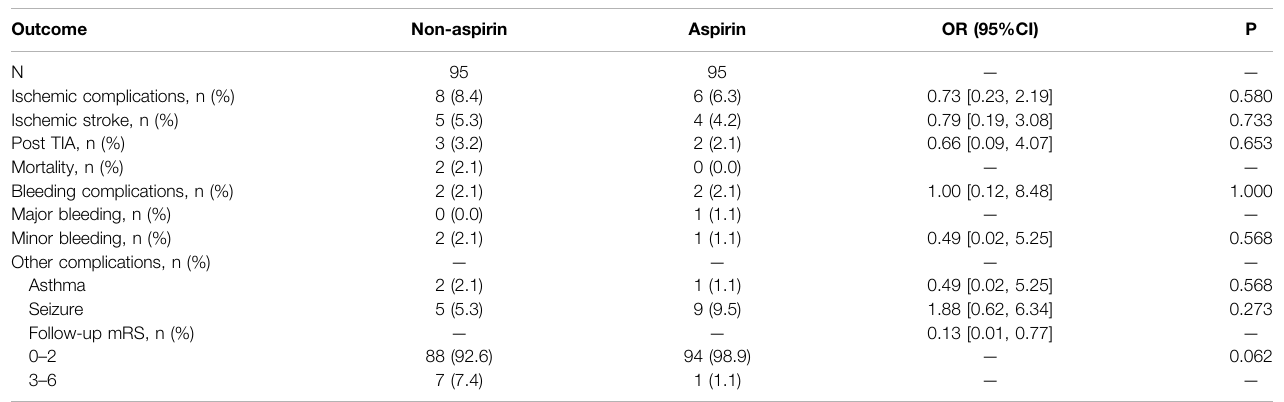
TABLE 4 | Risk of ischemic complications and bleeding events with postoperative drug therapy. Outcome